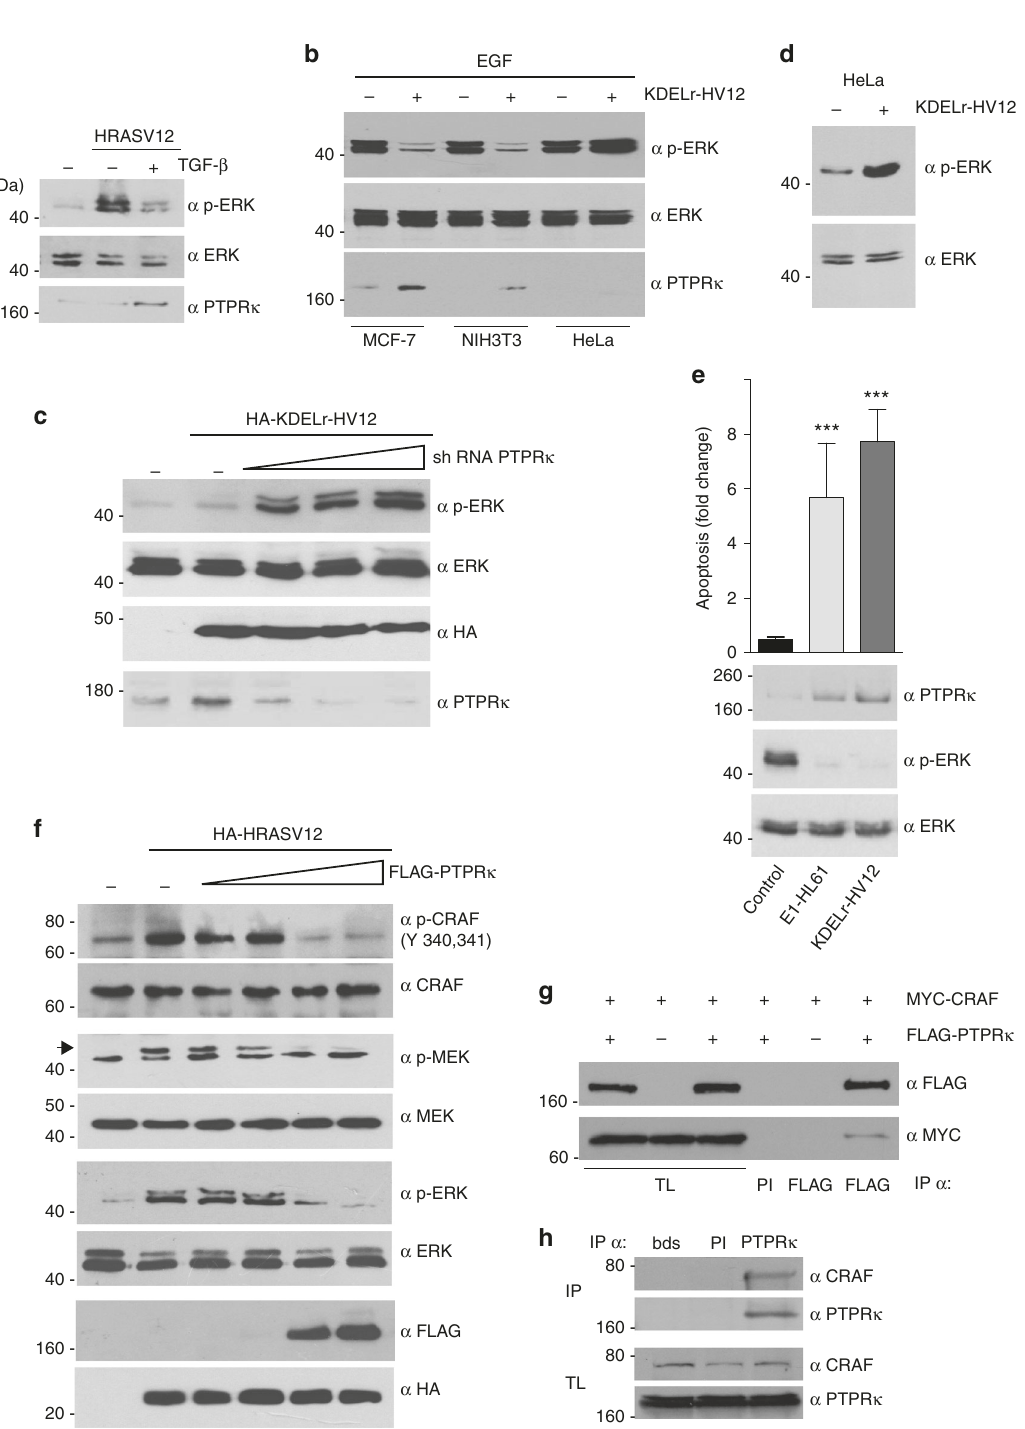
Fig. 6 GC RAS inhibits ERK activation via PTPR κ . a Induction of PTPR κ expression and downregulation of ERK phosphorylation by TGF- β (5 ng/ml for 2 h) in MCF-7 cells transfected with HRASV12 (1 μ g). b As in a , but by transfection of KDELr-HV12 (1 μ g) in the indicated cell lines stimulated with EGF (50